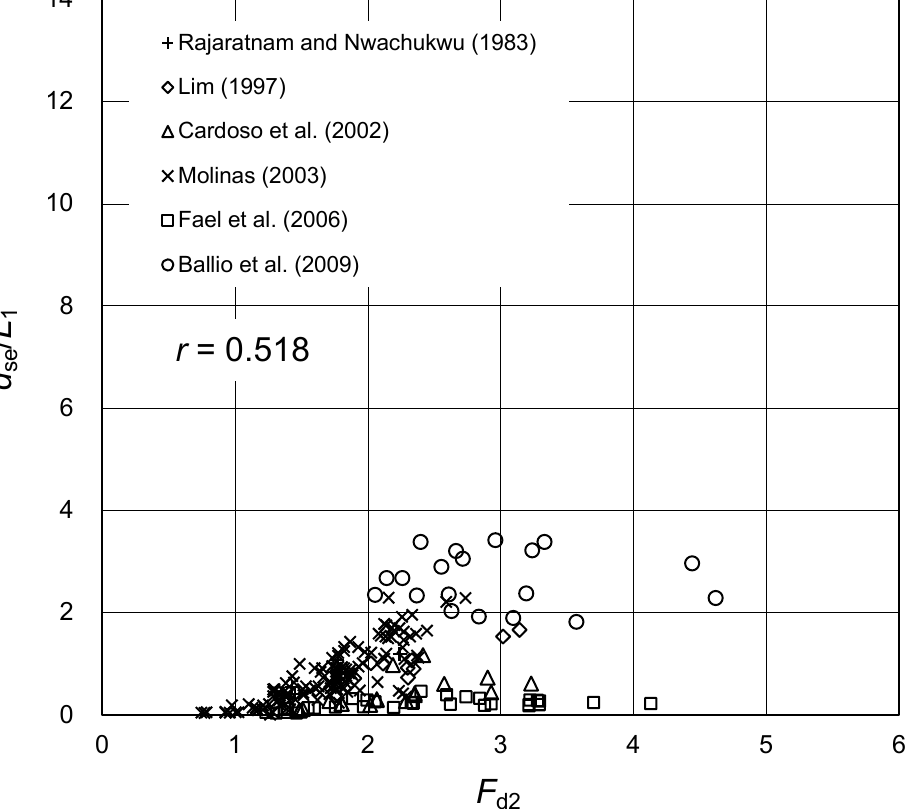
/(cid:1838) against (cid:1832) (cid:3046)(cid:3032) (cid:2869)